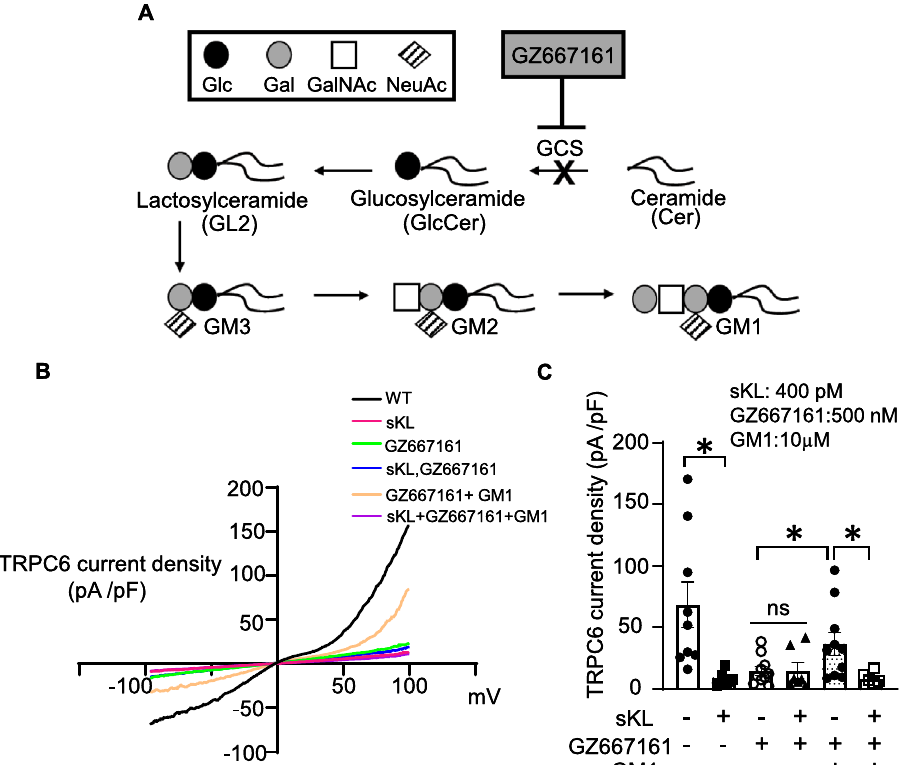
Figure 1. Effect of GZ667161 compound on sKL inhibition of TRPC6 in vitro. ( A ) Simplified diagram of the biosynthesis of gangliosides relevant to this study. Abbreviations: glucose (Glc), galactose (Gal), N-acetyl galactosamine (GalNAc), N-acetylneuraminic acid (NeuAc, sialic acid). ( B ) Representative current–voltage relationship (I-V) curve of TRPC6 current from experiments shown in panel C. ( C ) TPRC6 current in HEK293 cells overexpressing TRPC6 are treated with sKL, GZ667161, and/or GM1 (n = 5–10 per group) * P < 0.05 between indicated groups. ns, not significantly different between indicated groups. Data is expressed as mean ±